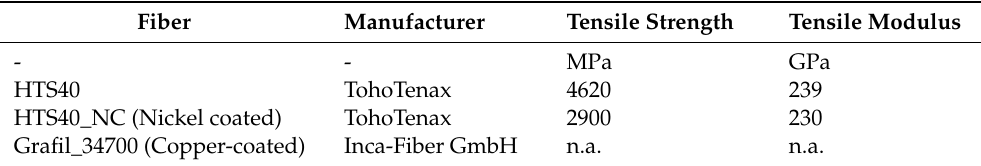
Table 1. Properties of fibers used in the underlying